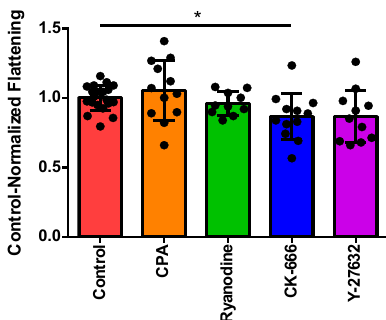
Figure 1. Characterizing changes in cell–substrate contact area in response to pharmacological in- hibitors. Each data point represents an individual eosinophil. Control-normalized cell flattening (see Section 2) in cells treated with vehicle (control; n = 20), CPA ( n = 12), ryanodine ( n = 10), CK-666 ( n = 12), or Y-27632 ( n = 11). * p < 0.05 by Kruskal–Wallis test.